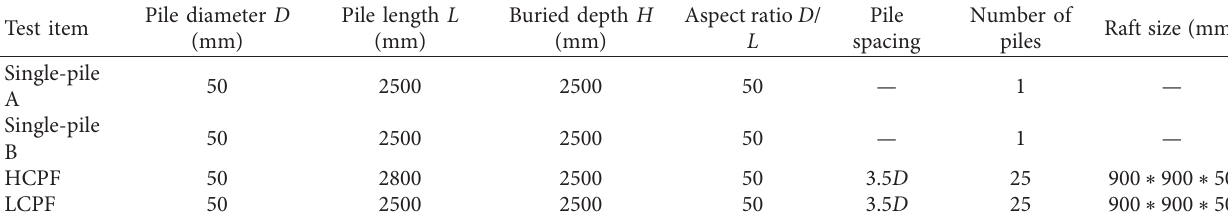
Figure 1: Model box system (mm). (a) Model box (strain gauges on the surface of the pile, soil pressure transducers (SPTs) among piles and laser displacement sensors (LDSs) on the cap). (b) Installation plan of model box and sensor configuration. Table 1: Parameters of the model